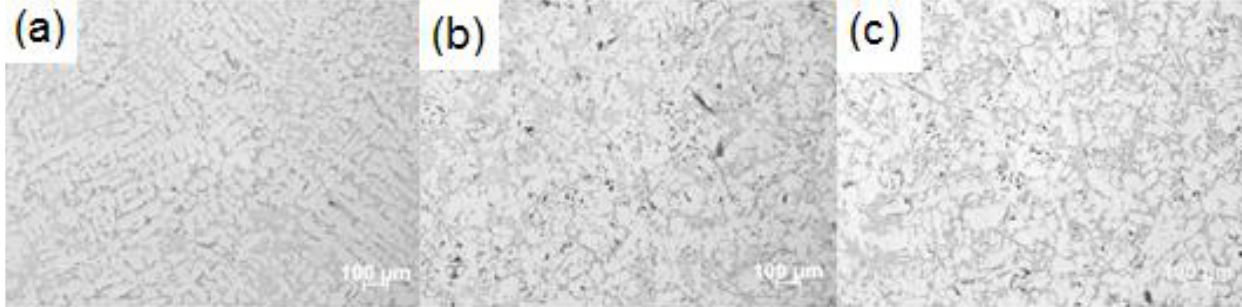
Figure 2. Optical micrographs showing the microstructure from ( a ) A332 alloy in as-cast condition without grain refiner; ( b ) with grain refiner Al5Ti2B; ( c ) with grain refiner Al5Ti1B. Pore formation was observed in all samples, though it was not significant. However, by El-Sayed